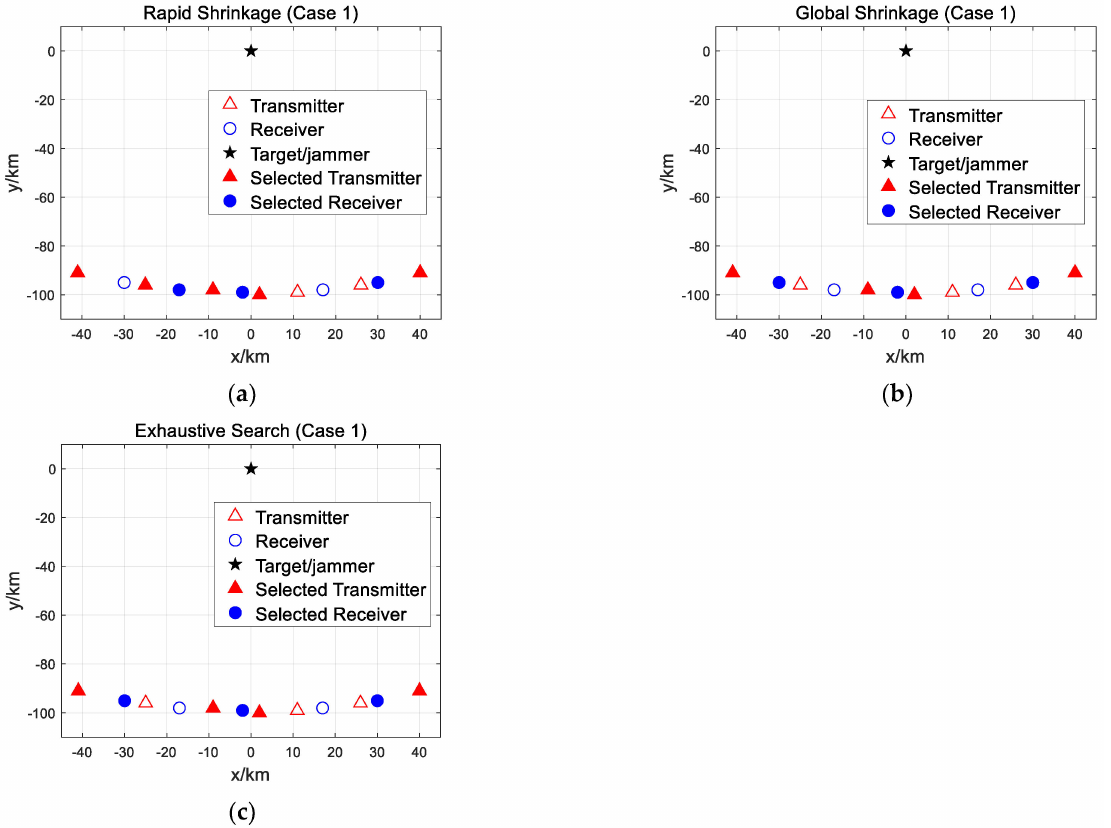
Figure 2. Simulation for three types of subset selection strategy in case 1: ( a ) subset selection strategy for rapid shrinkage; ( b ) subset selection strategy for global shrinkage; ( c ) subset selection strategy for exhaustive